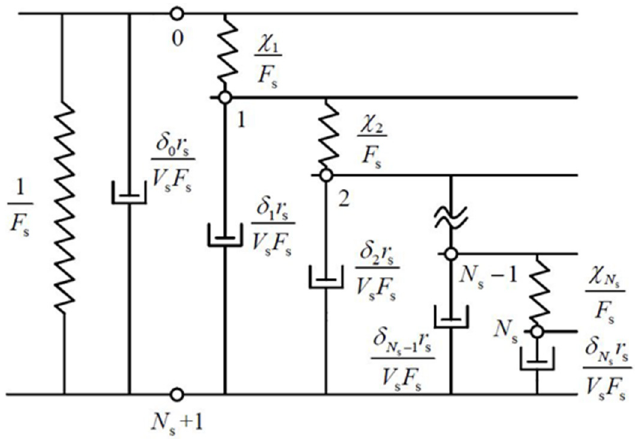
Figure 4. Nested lumped parameter model for soil foundation.